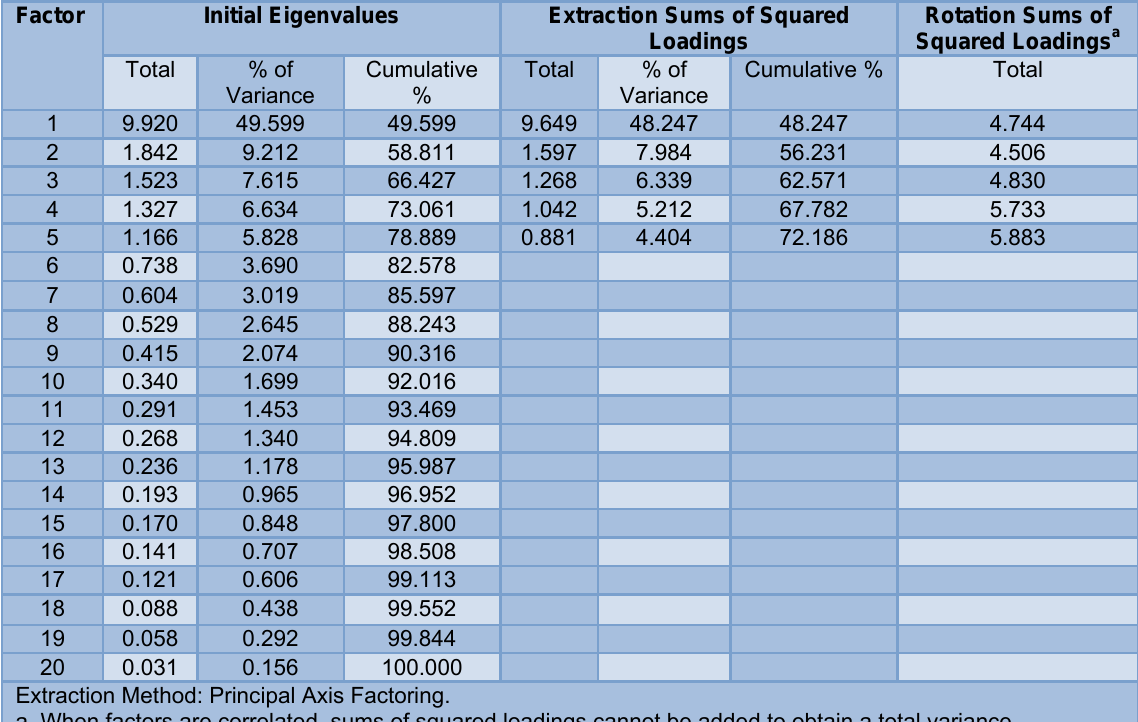
Table 3: Total Variance Explained for ET Decision Factor Initial Eigenvalues Extraction Sums of Squared